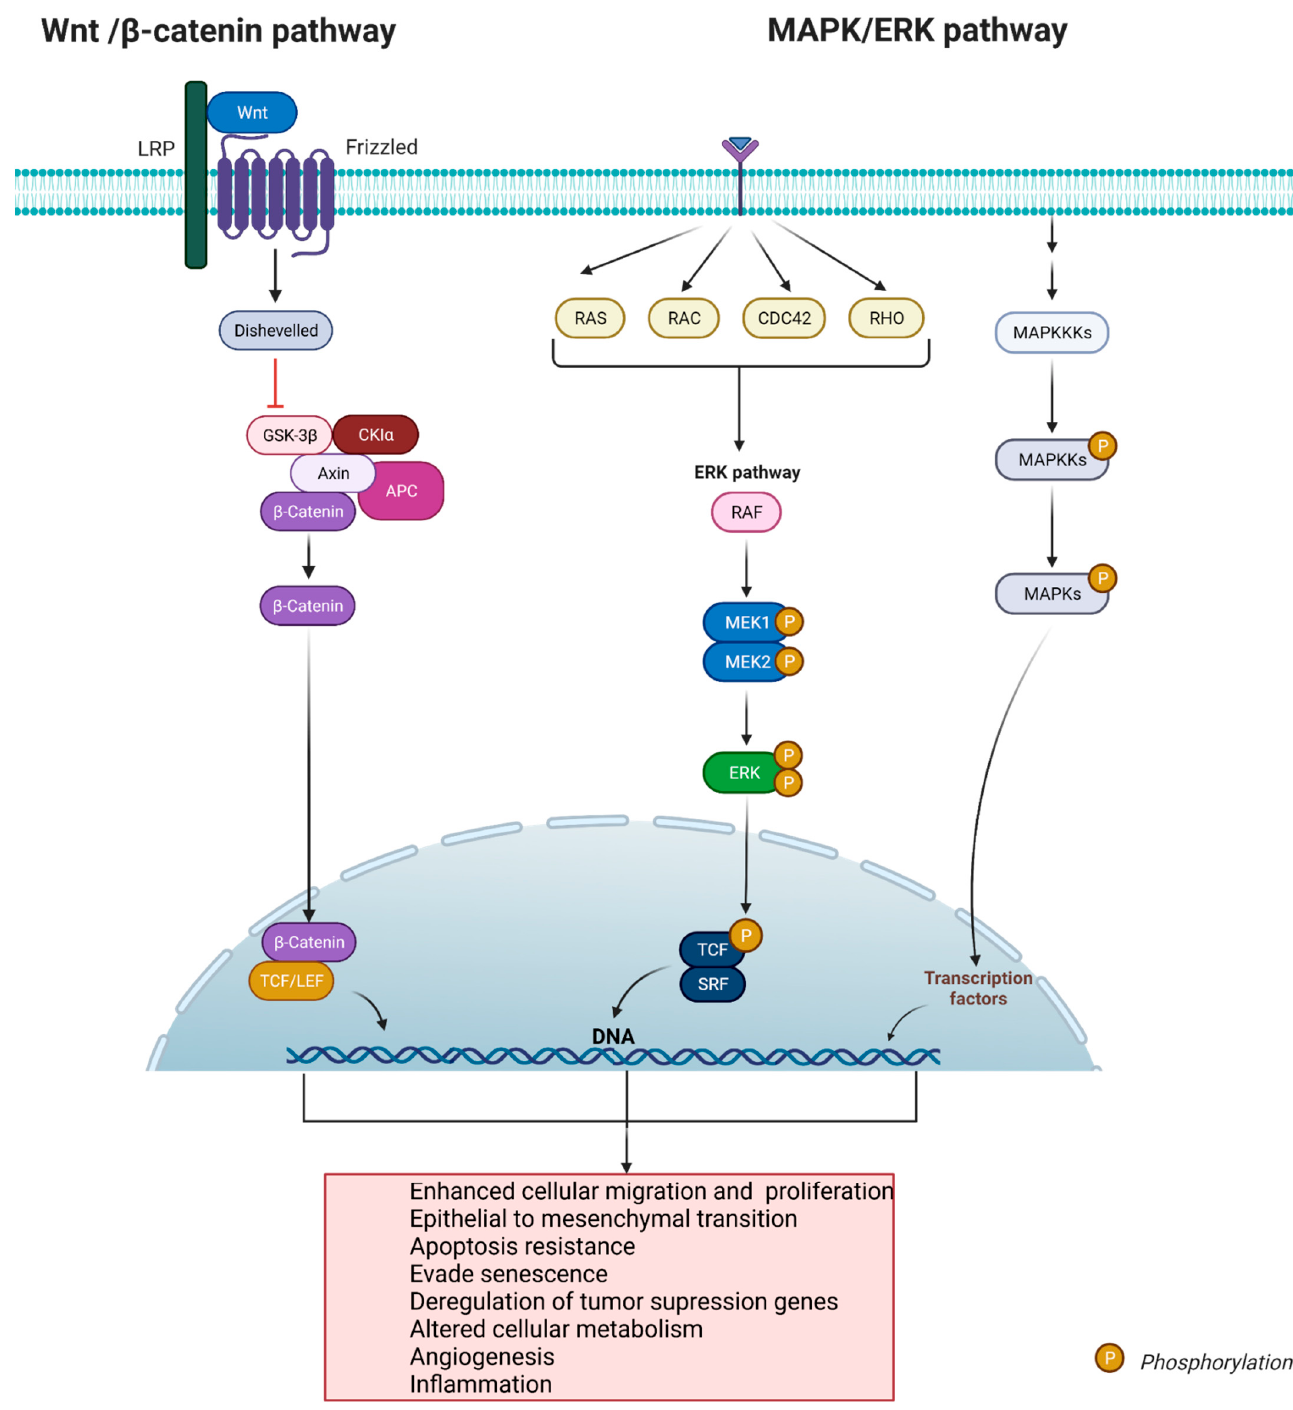
Figure 4. Representation of the molecular pathways involved in tumor formation and progression in CPs. The wingless (Wnt)/ β -catenin and the mitogen-activated protein kinases/extracellular signal-regulated kinase (MAPK/ERK) pathways, are the main biological cascades involved in the development of the two histological variants of CPs: ACPs and PCPs. Created with Biorender.com (accessed on 28 November 2021).